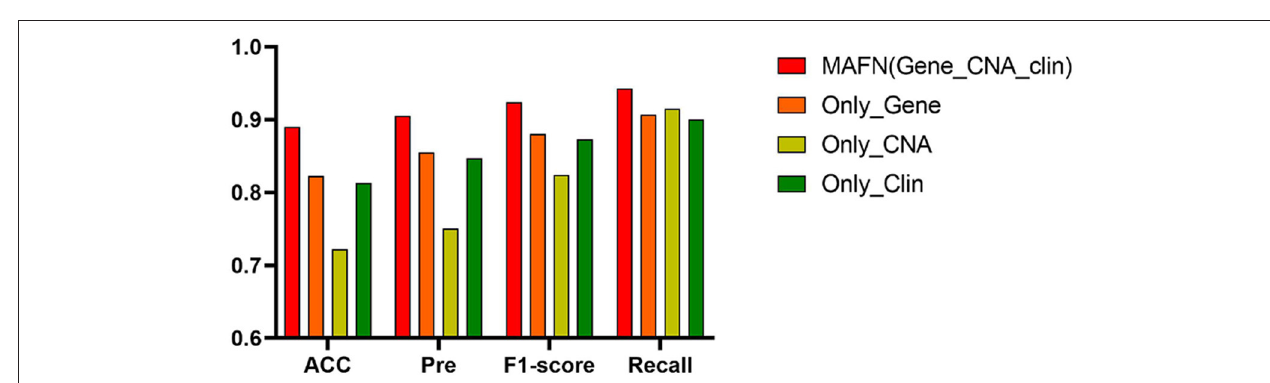
FIGURE 5 | Acc, Pre, F1-score, and Recall of multimodal affinity fusion network (MAFN) with different modality data.